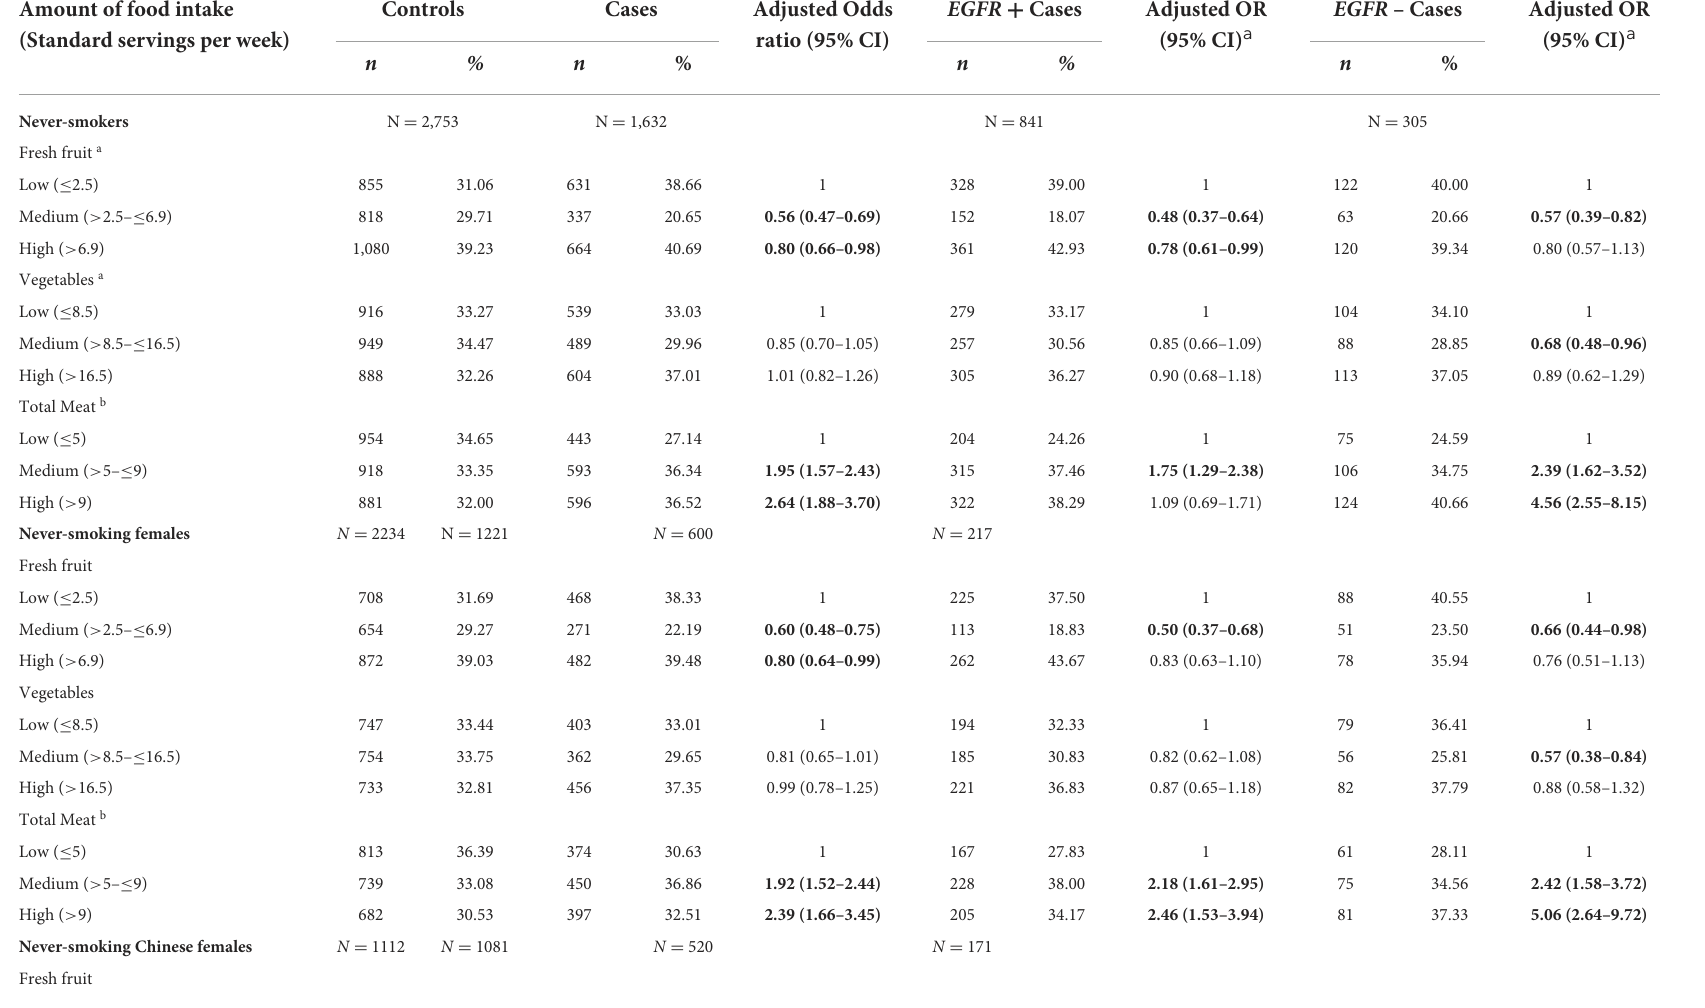
TABLE 4 Association between consumption of fruits, vegetables, and meat with risk of lung cancer among non-smokers. Amount of food